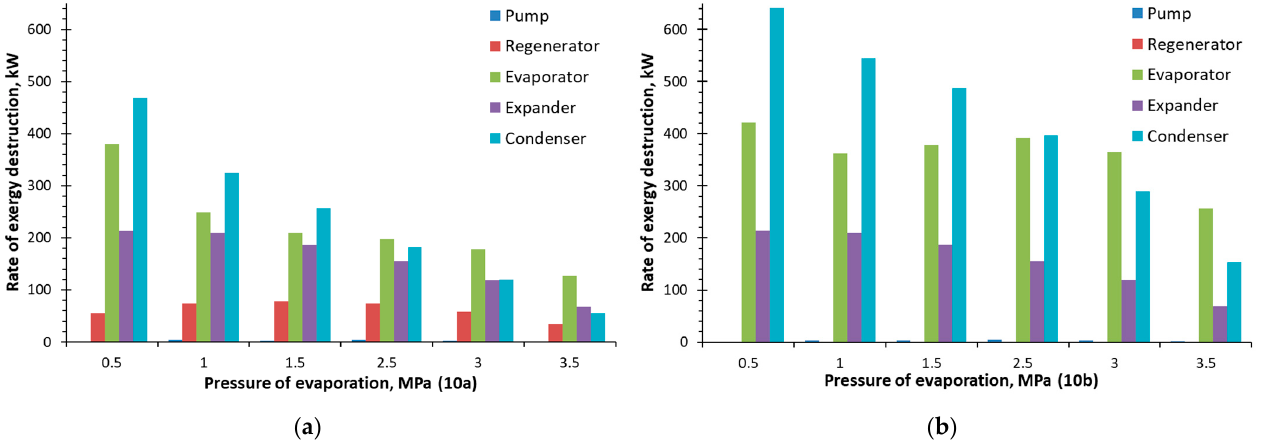
Figure 9. Rate of exergy destruction in the ORC cycle equipment using o-xylene: ( a ) with regenera- tion, and ( b ) without regeneration.